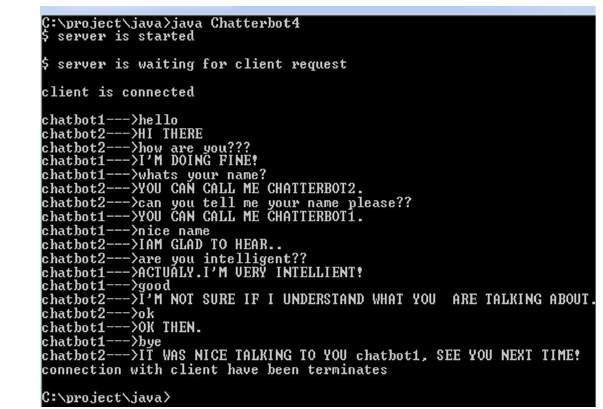
FIG. 5. AN INTERFACE OF SERVER